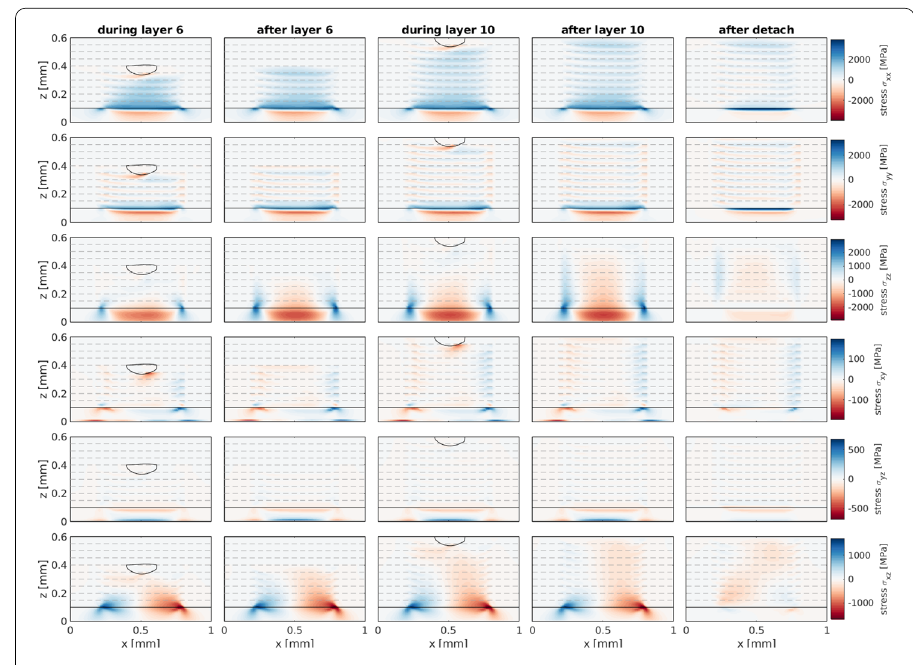
Fig. 15 Unidirectional scanning pattern: distribution of different stress components in symmetry plane at selected time steps. Blue color represents tension, red color represents compression. Liquidus isotherm (solid black line) approximates melt pool shape